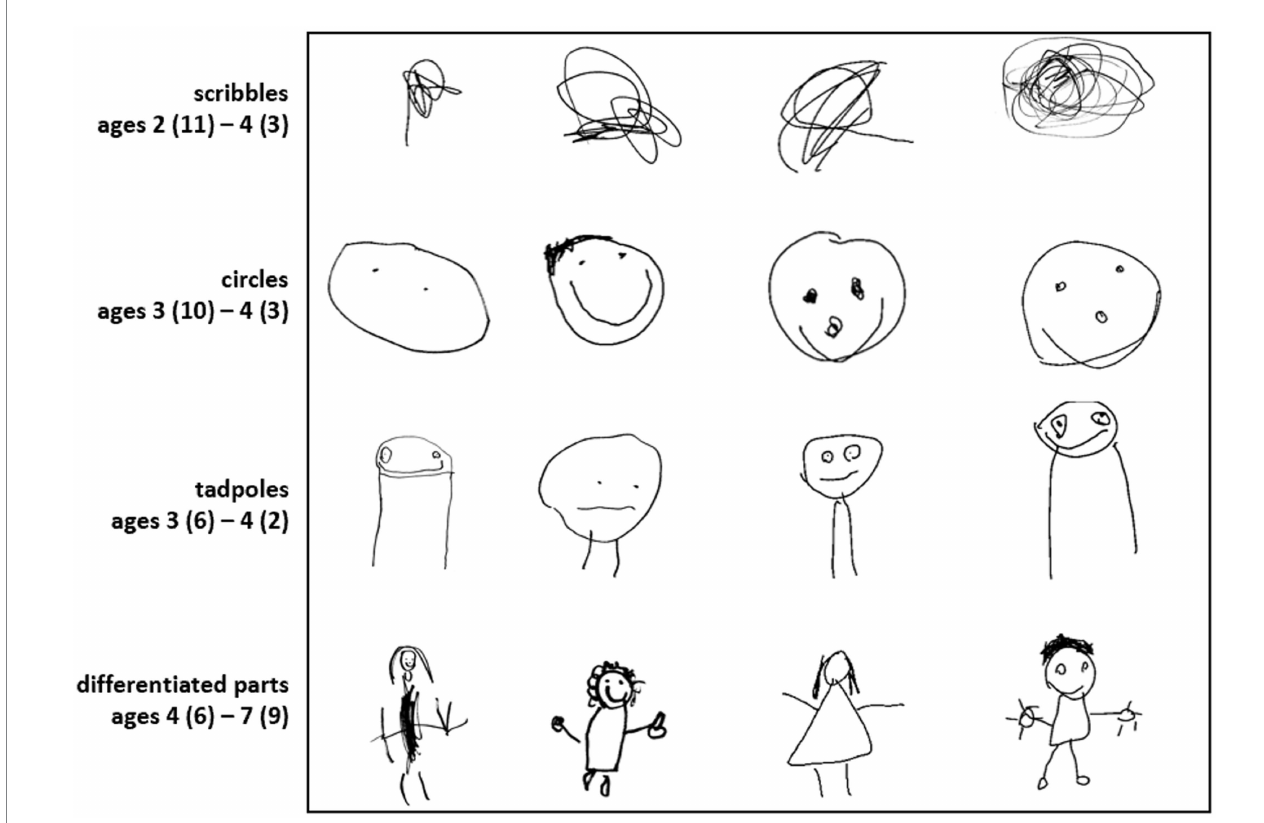
FIGURE 1 Patterns in human figure drawings across development. Examples of images produced in the drawing-across-media dataset, showing four common patterns previously identified in the